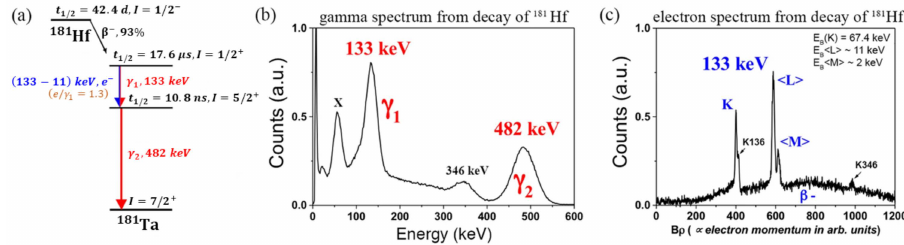
Figure 1. ( a ) The relevant decay paths of 181 Hf( 181 Ta), with the fractions representing the quantum number of the total angular momentum I of the particular state. More details could be found in reference [40]. ( b ) Emission spectrum of γ rays, with γ 1 at 133 keV and γ 2 at 482 keV. ( c ) Emis- sion spectrum of electrons, in which we take the <L> shell with an average energy of 122keV (133 keV–11 keV) for e − γ TDPAC spectroscopy. Adapted with permission from Ref. [31] under the